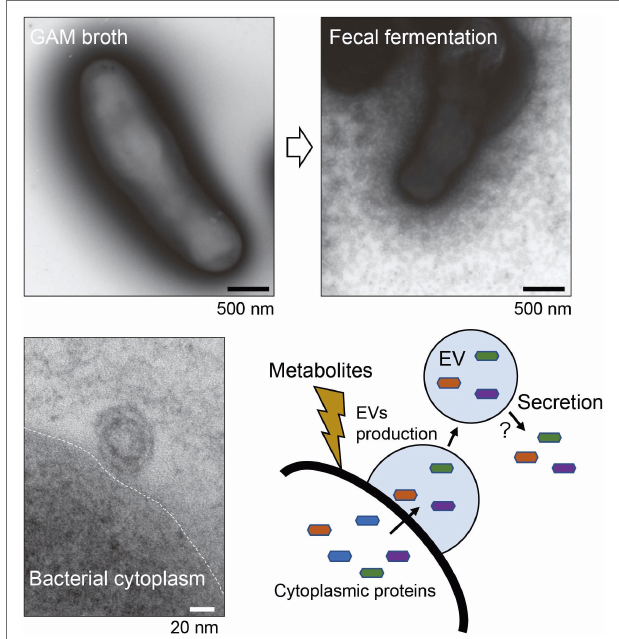
FIGURE 4 | Secretion of extracellular vesicles (EVs) by Bifidobacterium longum . Upper panels: B. longum NC2705 whole cells were negatively stained with uranyl acetate and examined under a TEM. Lower panel: ultrathin section of B. longum examined under a TEM. B. longum cultured in bacteria- free fecal fermentation broth secreted a myriad of EVs, probably in response to symbiotic microbiota-derived metabolites. The EVs contain several adhesive moonlighting proteins that may promote bifidobacterial colonization. This figure was adapted from Nishiyama et al. (2020) and Copyright © 2020 Kagakutoseibutsu (DOI: 10.1271/kagakutoseibutsu.58.614) with several